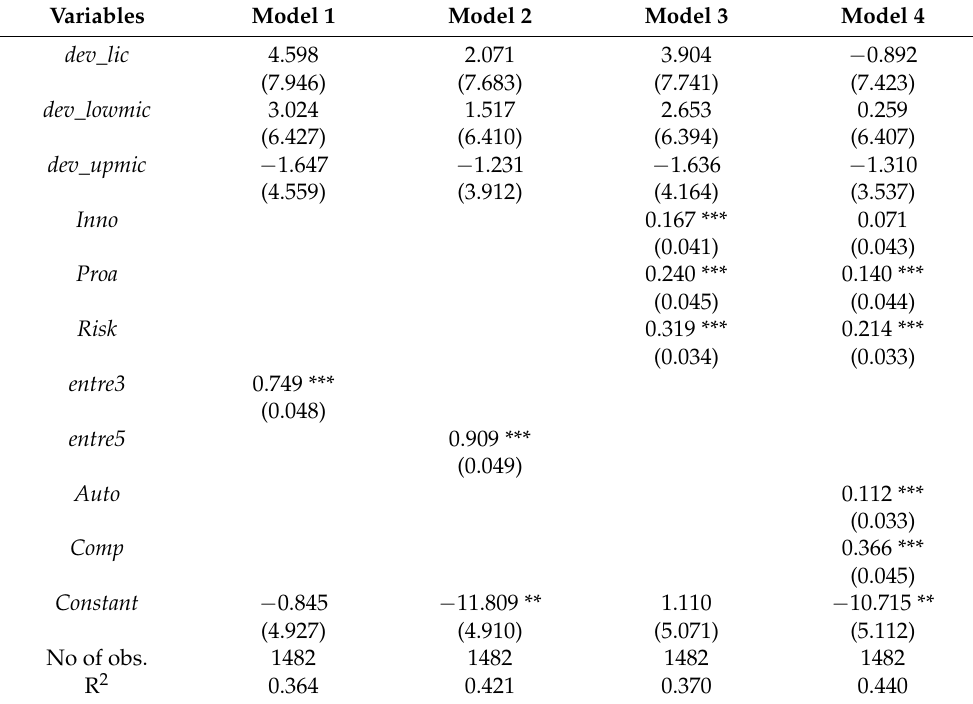
Table 2. Empirical results for the first dependent variable— hins (public healthcare